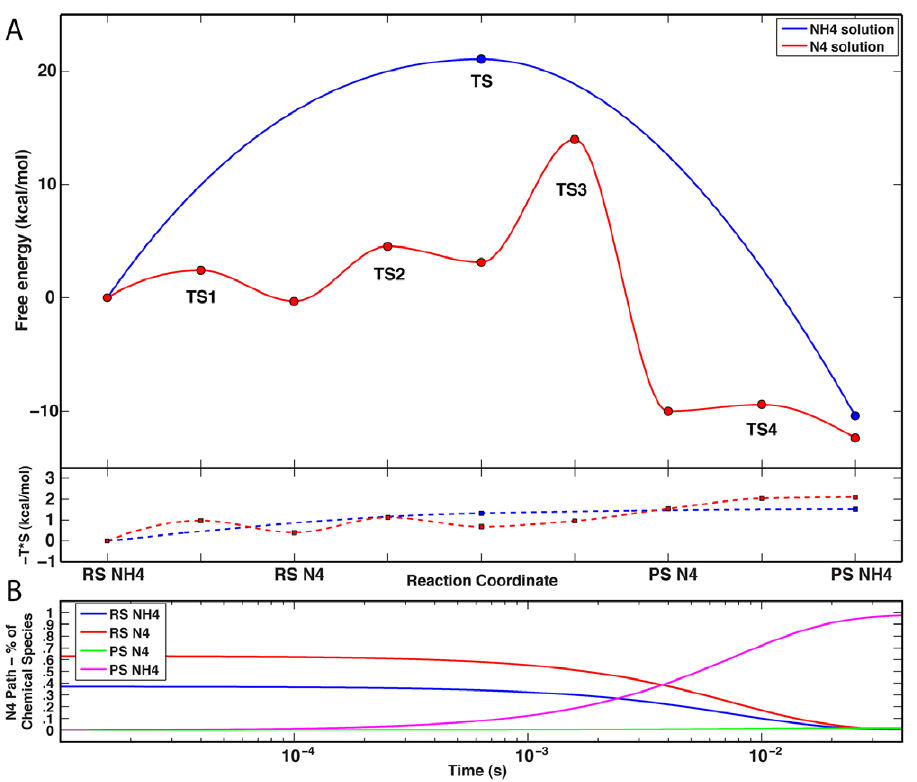
Figure 4. Free energy profiles of the cyclization reaction in solution. A. The profile of the reaction with N4 protonated (corresponding to the PES of Fig. 3 ) is shown in the upper quadrant as a blue line. The reaction coordinate axis is in arbitrary units and the reactant and product states are marked as RS NH4 and PS NH4, respectively. The profile of the reaction with N4 deprotonated is shown as a red line in the upper quadrant. The actual reactant and product states of the cyclization reaction (corresponding to PES II in Fig. 5 ) are marked as RS N4 and PS N4, respectively. In order to place this reaction on the same energy scale as the reaction with N4 protonated, two additional steps were calculated representing the protonation of RS N4 to RS NH4 (PES I in Fig. 5 ), and the protonation of PS N4 to PS NH4 (PES III in Fig. 5 ). Circles on the profiles mark the positions along the reaction coordinate (TSs and stationary points) where thermochemical properties were calculated with a vibrational analysis. All other values reflect only a shape-preserving interpolation between the calculated points. Changes in the entropic contribution ( 2 T*S) to the free energy curves are shown in the lower quadrant with red and blue dashed lines and square markers for the NH4 and N4 pathways, respectively. B. Time course of the reaction corresponding to the red trace in panel A, starting from 100% hydrolyzed biapenem with N4 ionized (RS N4 in panel A). The almost instantaneous (between 0 and 10 2 5 s) protonation of RS N4 to RS NH4 (due to the very low barrier at TS1) is not shown.